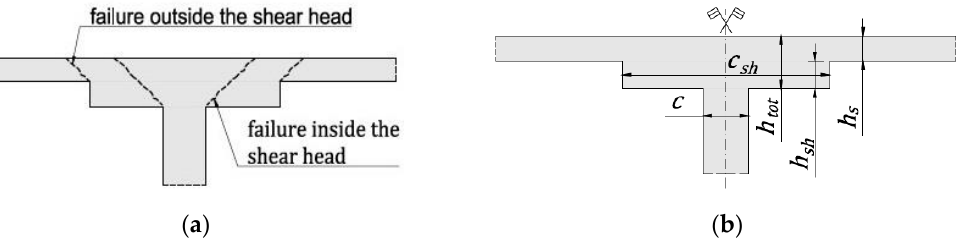
Figure 1. Slab–column connection with shear head: ( a ) potential failure region; ( b ) denotations: thickness of shear head ( h sh ), thickness of slab ( h s ), total thickness ( h tot ), column span ( c ), shear head span ( c sh